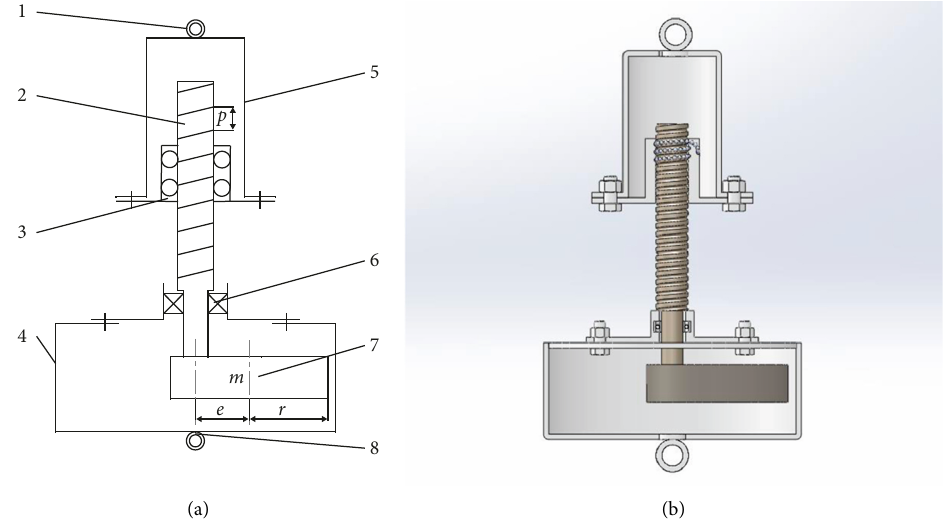
Figure 1: Schematic of the eccentric inerter.